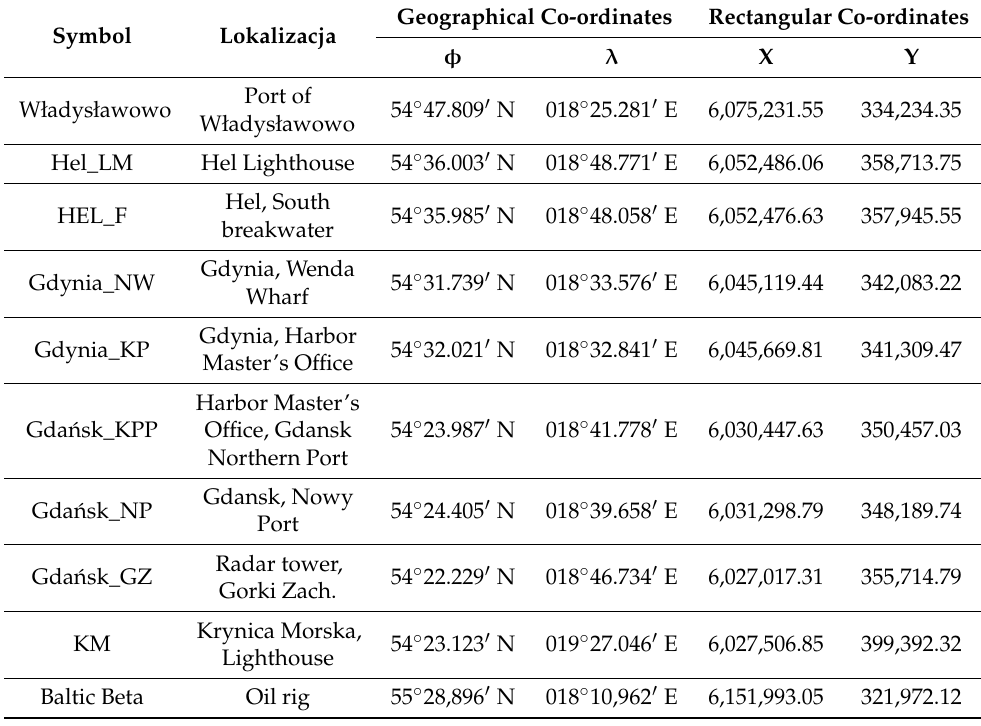
Table 1. Co-ordinates of the coastal radar stations in the VTS Zatoka Gda´nska system.